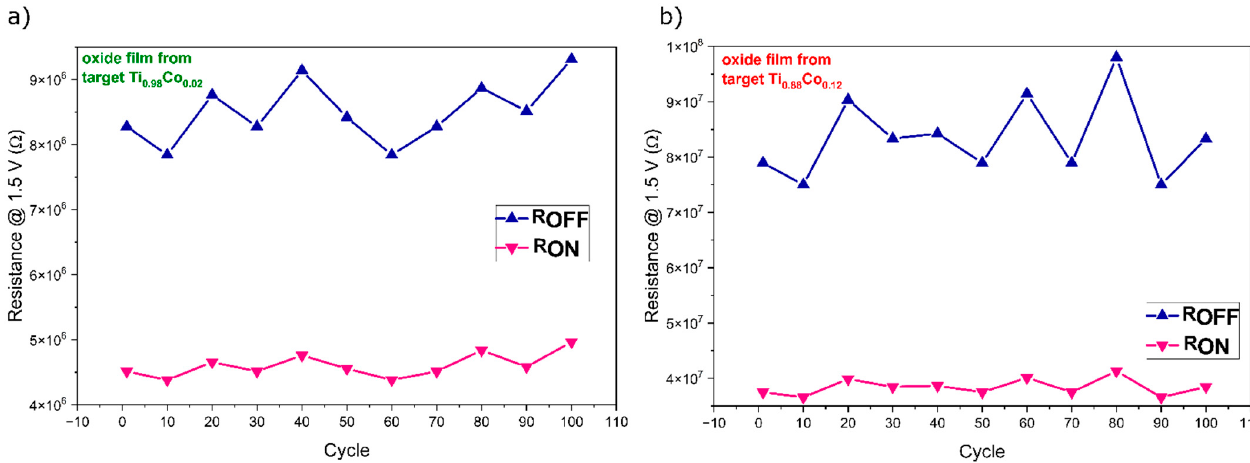
Figure 14. Retention plots of prepared Au/(Ti,Co)Ox/Si structures with different cobalt concentration—prepared from: ( a ) Ti 0.98 Co 0.02 and ( b ) Ti 0.88 Co 0.12 targets.